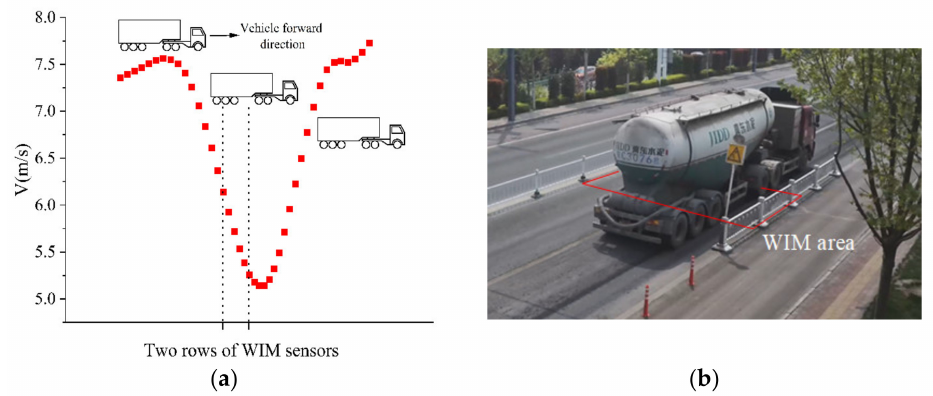
Figure 14. The effect of the position and speed correspondence of the truck (No.17) on the scale. ( a ) Map of the correspondence between the position and speed of the truck; ( b ) Map of the truck passing through the weighing area.